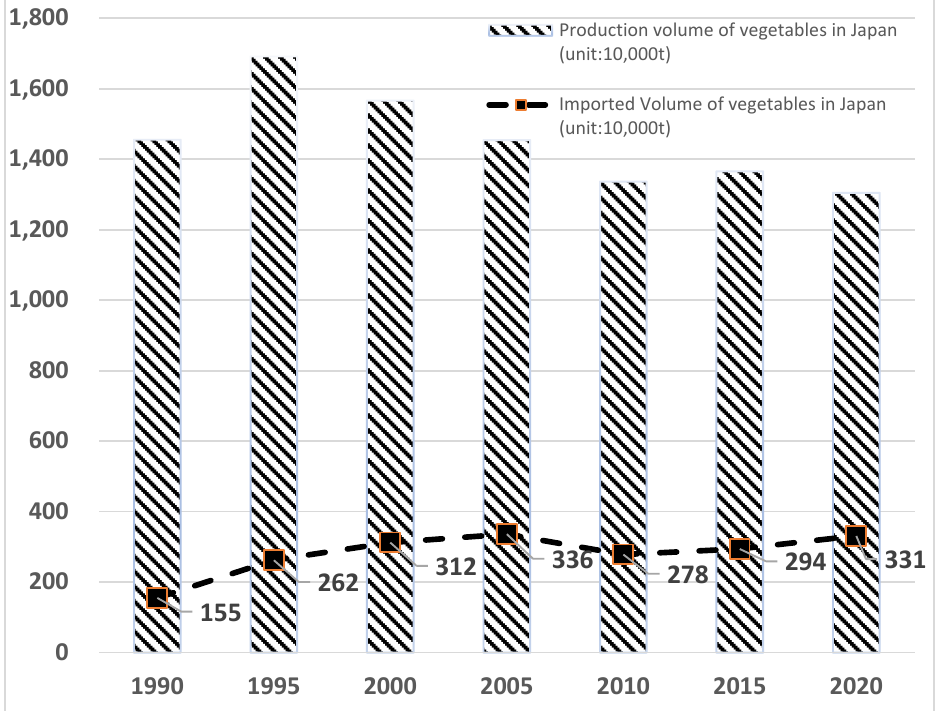
Source: Agriculture and Livestock Industries Corporation of Japan (JALIC) Statistics. Figure 2. Trends in import volume of vegetables including processed goods. Figure 2. Trends in import volume of vegetables including processed